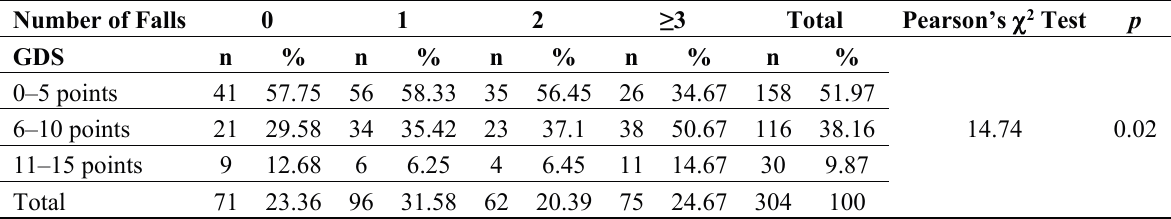
Table 5. The correlation between the number of falls and the results of the GDS (Pearson’s correlation coefficient).